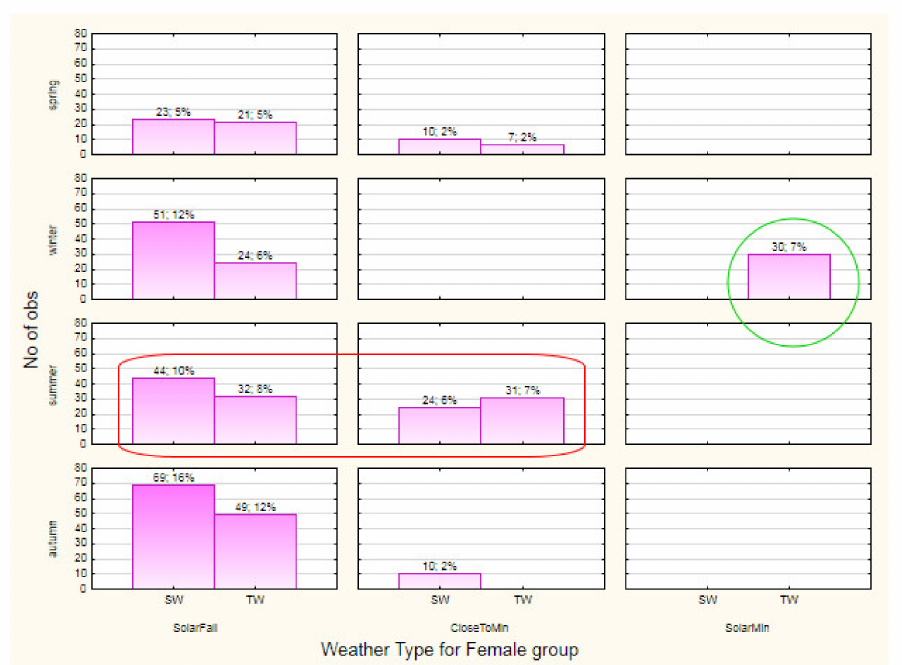
Figure 6. The distribution of the ratio between Space Weather (SW) and Terrestrial Weather (TW) characteristics, which differ when they are corresponding to the different medical events, by the solar activity cycle phases and calendar seasons. Female group from the medical call logs for the ischemia cases. The color contours are explained below in the main text of the article.